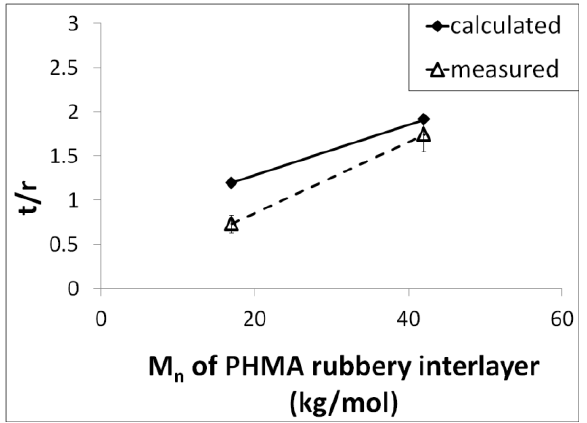
Figure 4. A comparison between the measured and calculated ratio of the rubbery interlayer thickness (t) and the radius (r) of the particle cores for particles with a 20 kg/mol and 40 kg/mol PHMA rubbery